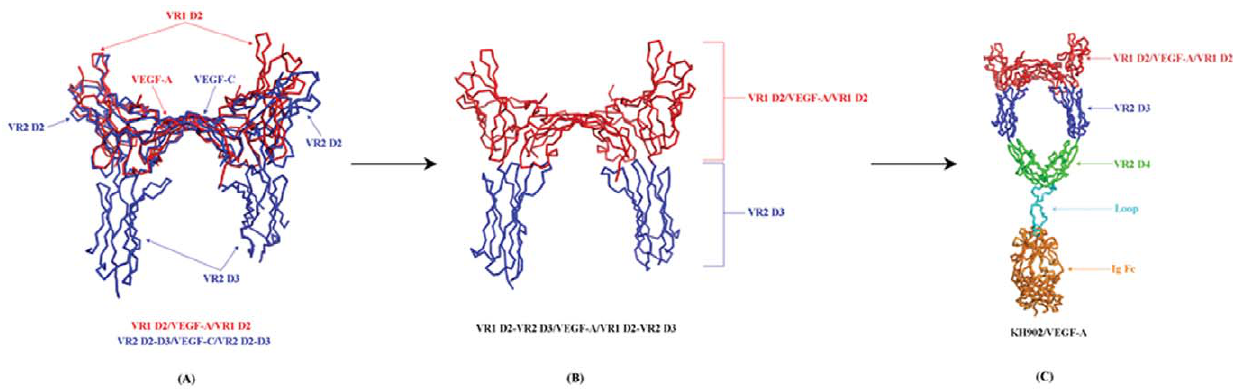
Figure 1. A brief description of the construction of the conbercept–VEGF-A complex model: (A) Alignment of VR1 D2/VEGF-A/VR1 D2 and VR2 D2–D3/VEGF-C/VR2 D2–D3 crystal structures. ( B ) Grafting VR2 D3 from VR2 D2–D3/VEGF-C/VR2 D2–D3 to VR1 D2/VEGF-A/VR1 D2 on the basis of the alignment. ( C ) Adding VR2 D4, loop, and IgG Fc to the VR1 D2-VR2 D3/VEGF-A/VR1 D2-VR2 D3 to obtain the conbercept–VEGF- A complex